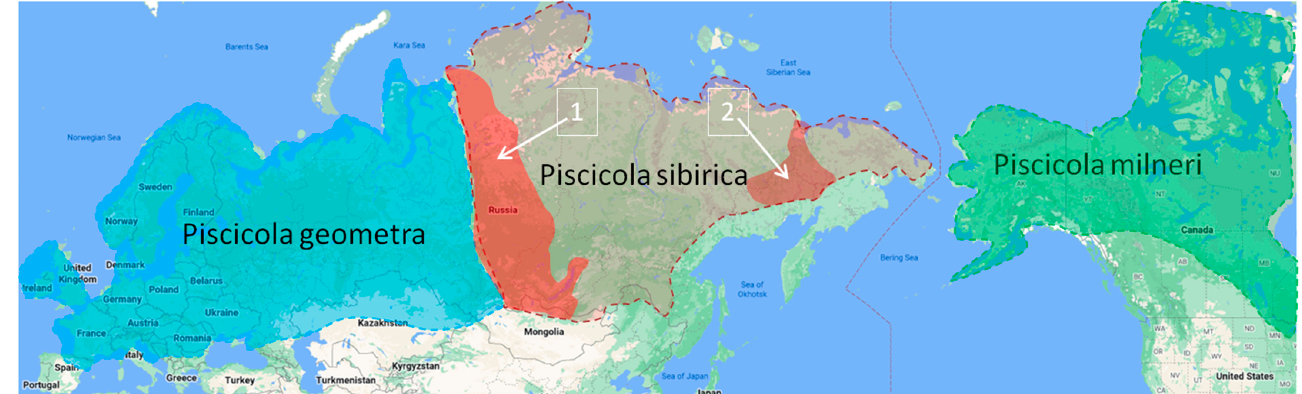
Figure 9. Biogeography of vicarious species of Piscicola in the Northern Hemisphere: Extrapolation of distribution and occurrence data on Piscicola geometra (light-blue area), Piscicola milneri (light-green area), and Piscicola sibirica sp. nov. (light-red area) collected under this study and from publicly available records. The watershed areas of the Baikal–Angara and the Yana River (regions where Piscicola sibirica sp. nov. was recorded) are highlighted in red and marked with numbers 1 and 2, respectively.